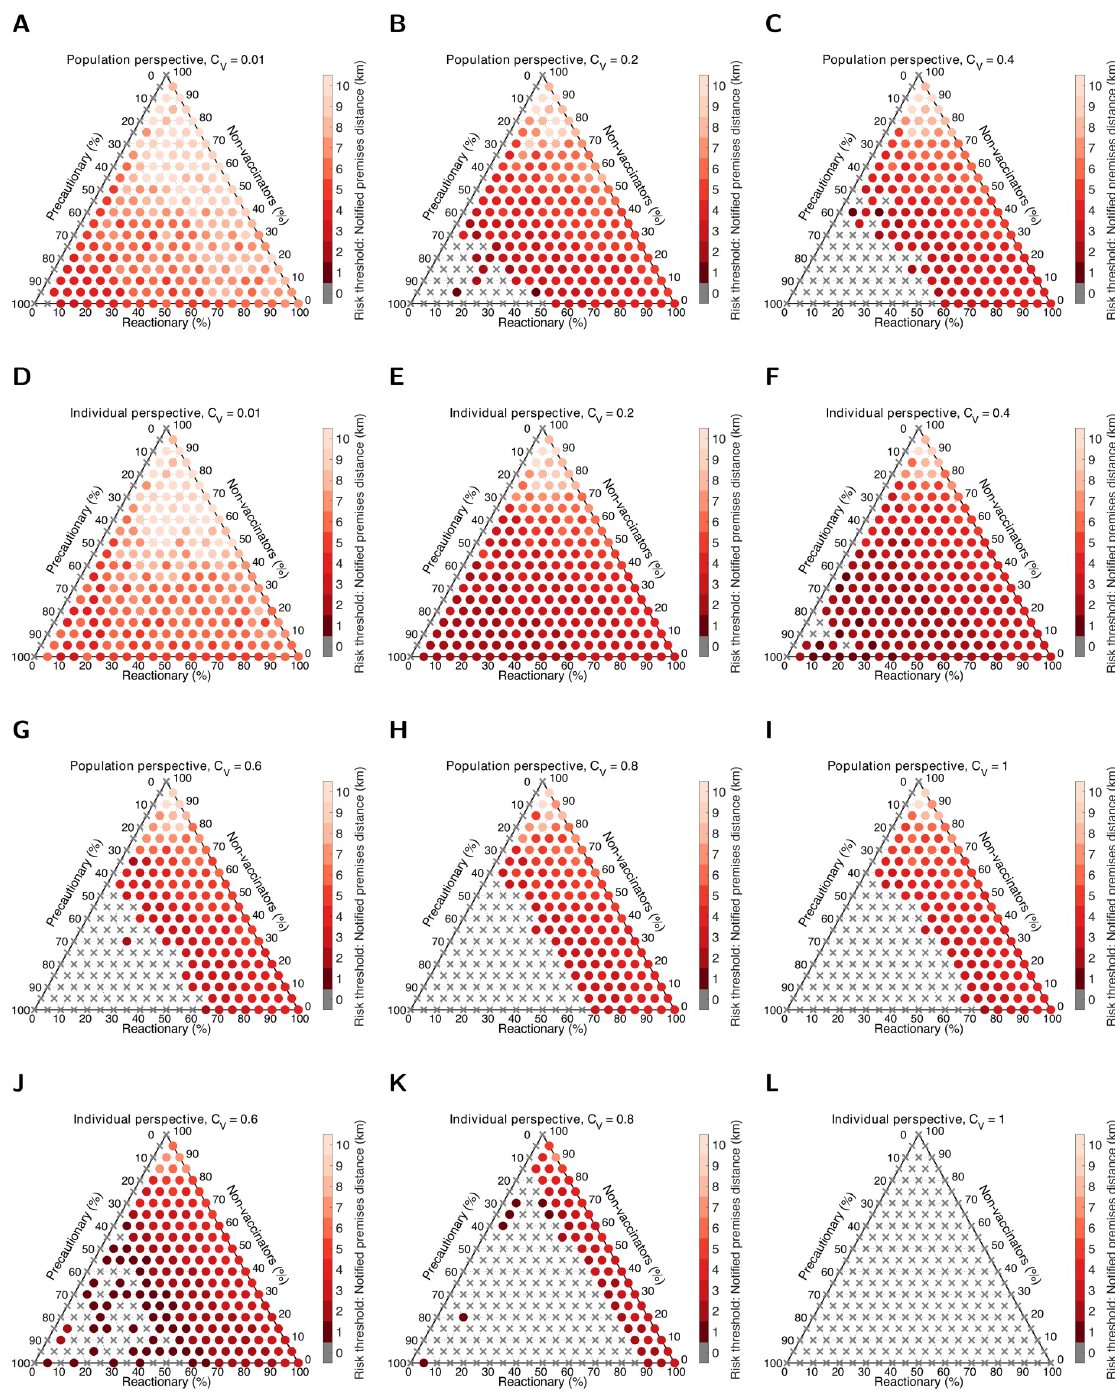
Fig 3. Strategy that minimises overall cost in Cumbria, dependent on the perspective, relative cost of vaccination and vaccine group composition. We performed 500 replicates per scenario. Shading corresponds to the notification distance risk threshold d that returned the lowest median cost across the control scenarios (dark to light corresponding to increases in distance from 1km to 10km). Grey crosses correspond to no reactive vaccination occurring. The ternary plots display optimal strategies from the population and individual perspectives given a relative cost of vaccination, C V , of: A,D 0.01; B,E 0.2; C,F 0.4; G,J 0.6; H,K 0.8; I,L 1. For an explanation on reading values on a ternary plot, see Fig B in the S1 Text.